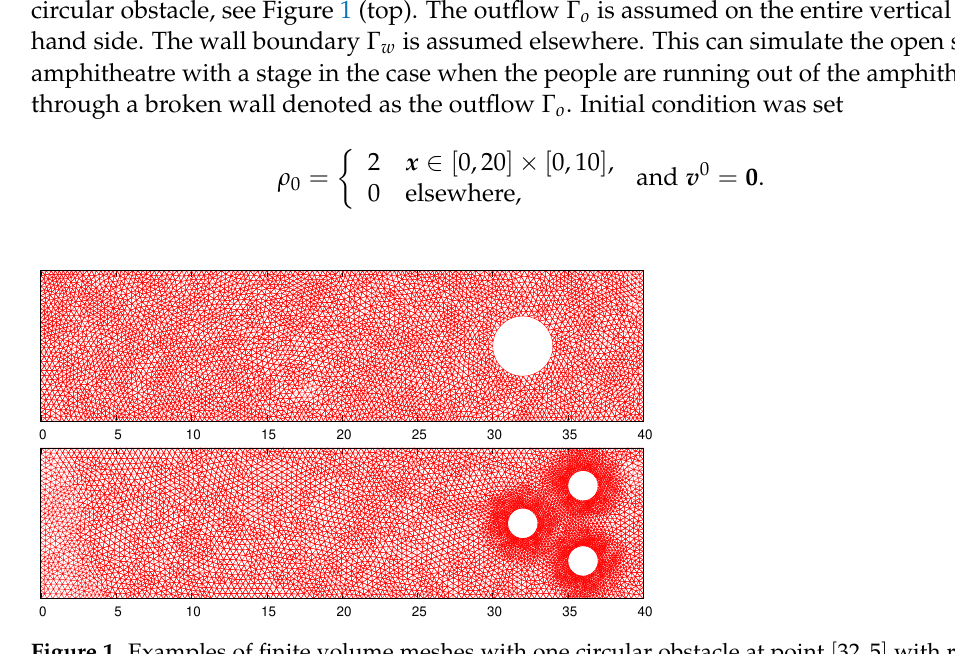
Figure 1. Examples of finite volume meshes with one circular obstacle at point [ 32,5 ] with radius R = 2m ( top ) and with three circular obstacles at points [ 32,5 ] , [ 37,2.5 ] and [ 37,7.5 ] with radius R = 1m ( bottom ).